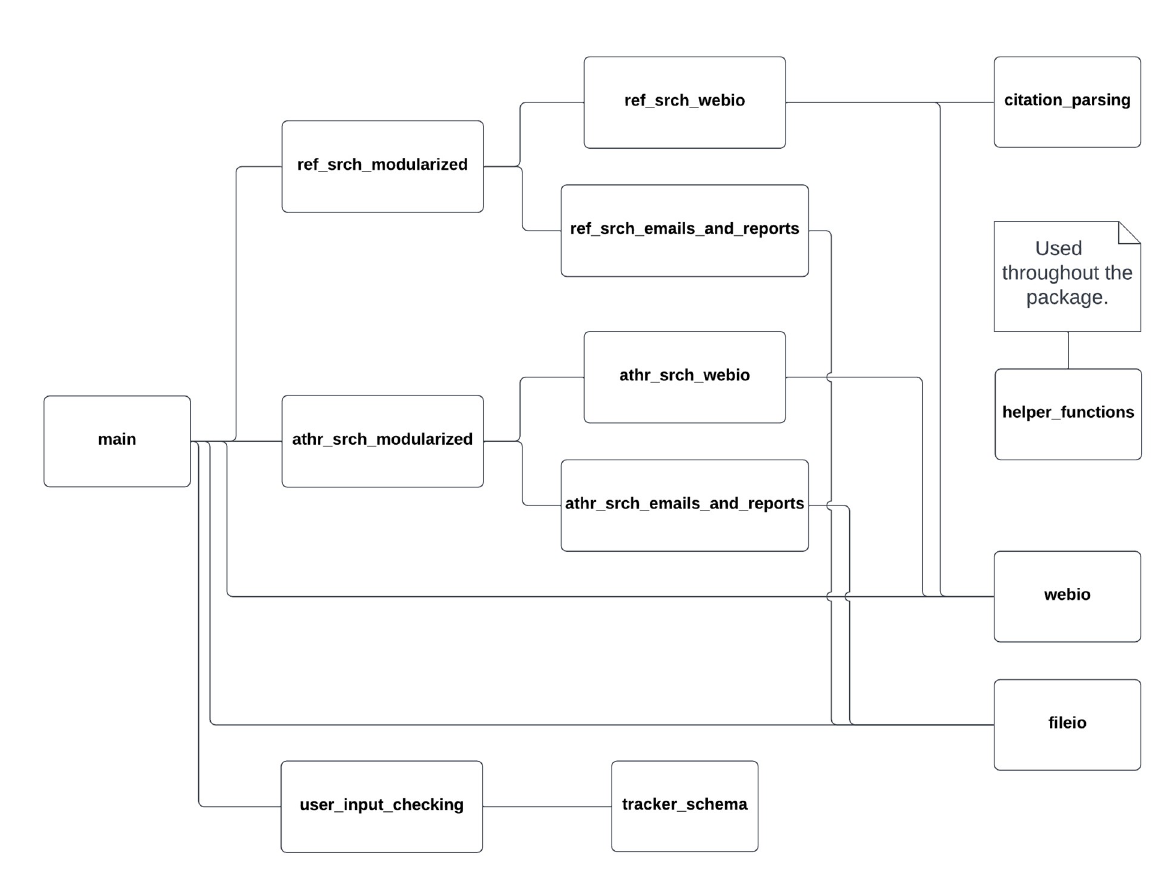
Fig 2. Academic Tracker module diagram. Submodule and module dependencies are illustrated by connecting lines, except for helper_functions which is utilized by most other submodules.